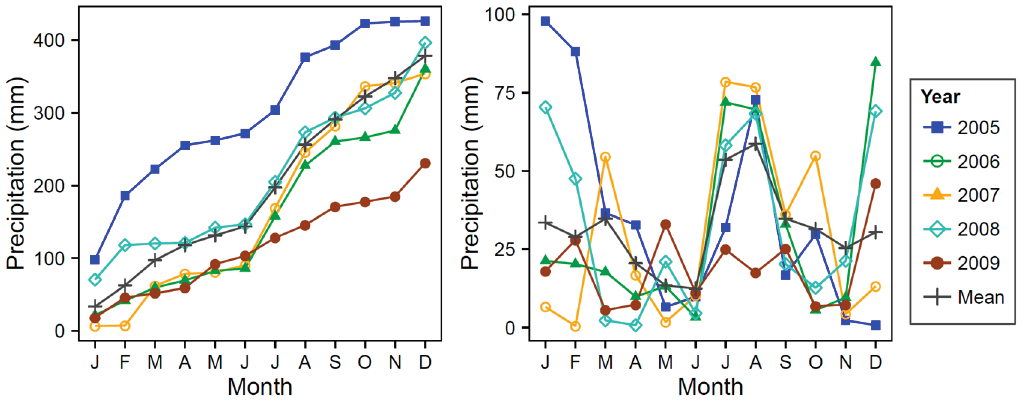
Figure 2. Precipitation recorded in National Climatic Data Center (NCDC) Climate Division II in Arizona from 2005 to 2009, shown as ( left ) cumulative monthly totals, and ( right ) total monthly